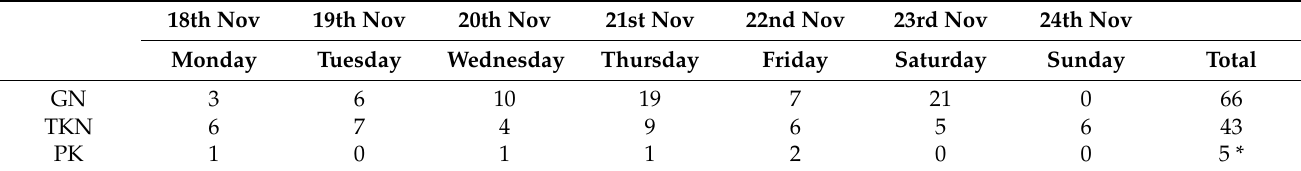
Table 4. Share of the number of tweets on subsequent days of the week (N = 114).